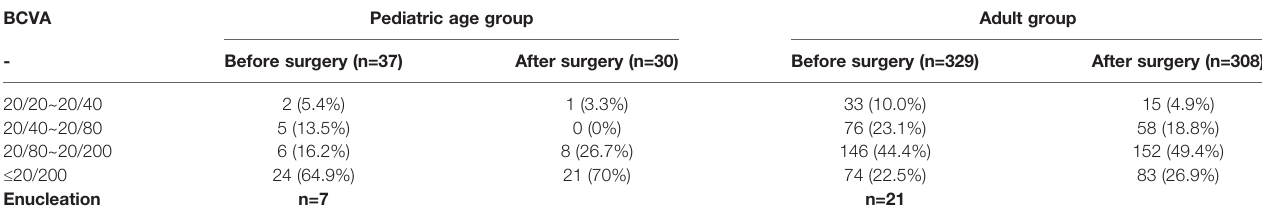
TABLE 3A | BCVA of 366 patients before and after surgery of PTSU and MVRE.